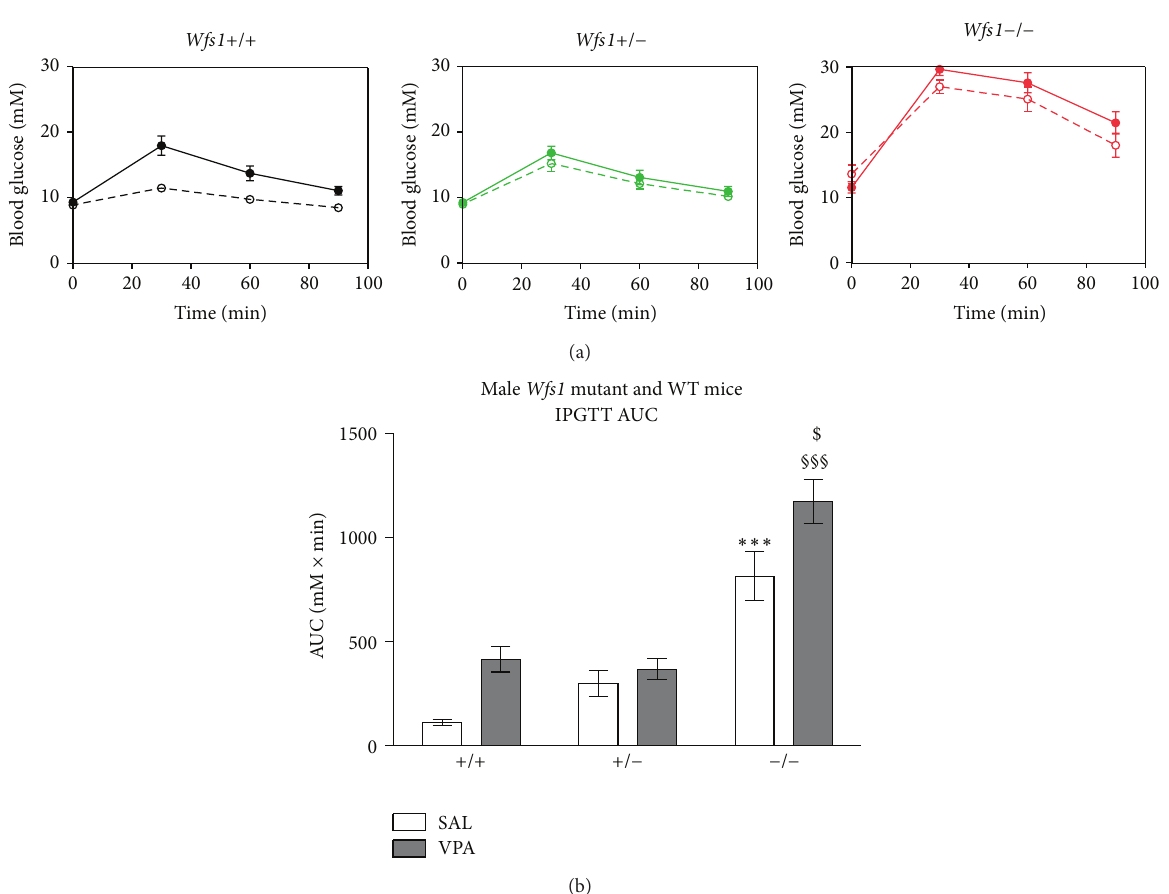
Figure 2: Glucose tolerance test in male WT and Wfs1 mutant mice after 3-month VPA treatment (300 mg/kg/day). (a) Time course of blood glucose levels following glucose challenge (2g/kg, i.p.). Blood glucose was measured from tail vein immediately before and 30, 60, and 90 minutes following glucose administration. VPA treatment (solid circles) had no effect on glucose tolerance in Wfs1 KO or Wfs1 HZ mice when compared to respective vehicle group (0.9% saline, 10mL/kg, i.p., open circles). (b) Area under the curve of glucose time curves. Two-way ANOVA followed by Tukey’s HSD test ( ∗∗∗ 𝑃 < 0.001 versus (+/+SAL); §§§ 𝑃 < 0.001 versus (+/+VPA); $ 𝑃 < 0.05 versus ( − / − SAL)). Data is presented as mean ± SEM ( 𝑛 = 8